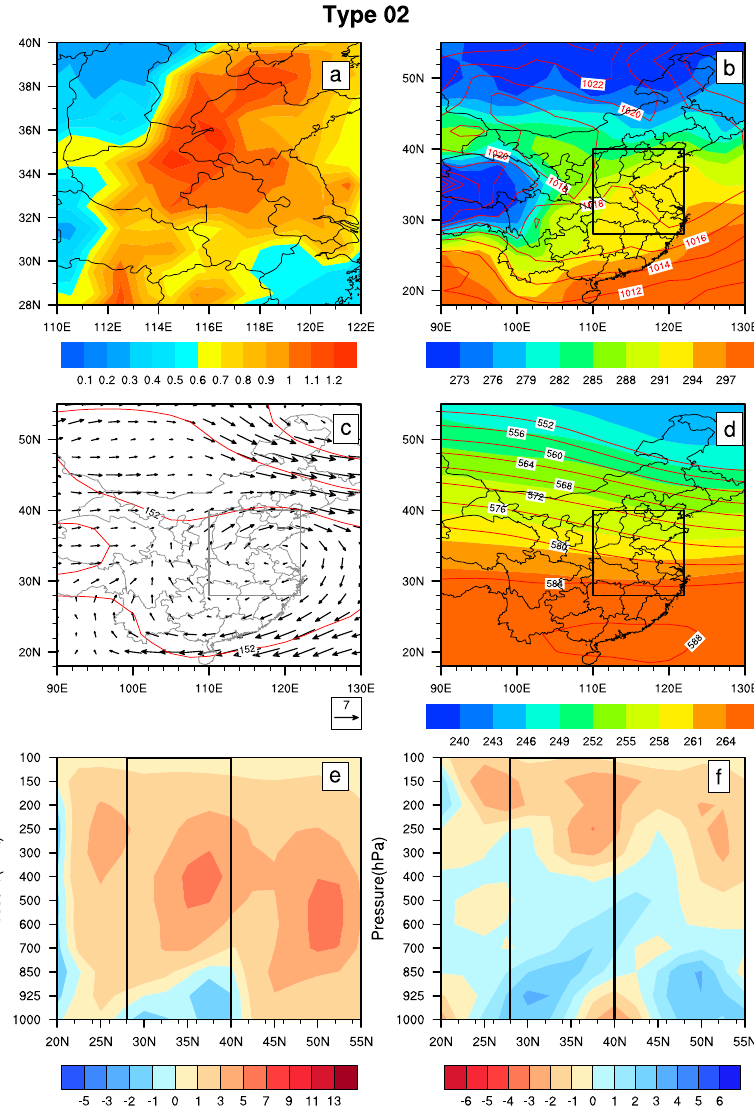
Figure 9. As in Fig. 8 but for Type 2